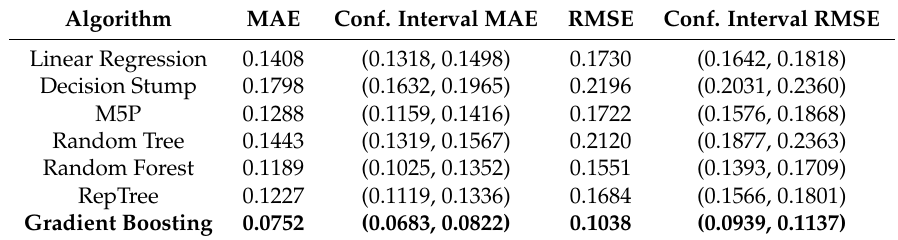
Table 4. Evaluation of ML techniques using the Local Approach: Mean of MAE and RMSE, 99% confidence interval. The best performers are highlighted in bold .